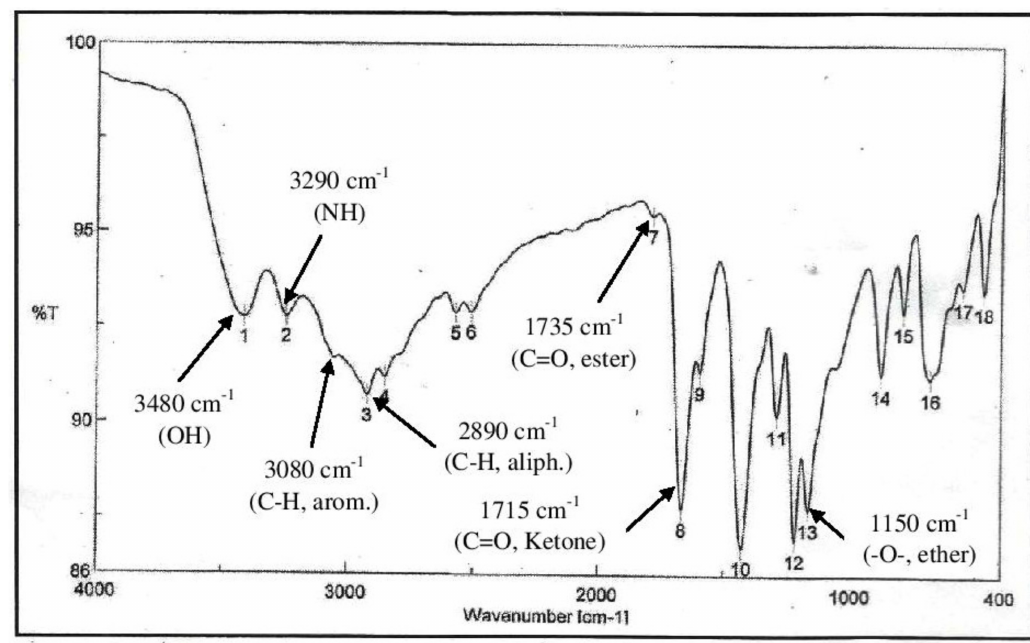
Figure 8. IR spectrum in KBr (discs) for the extraction of